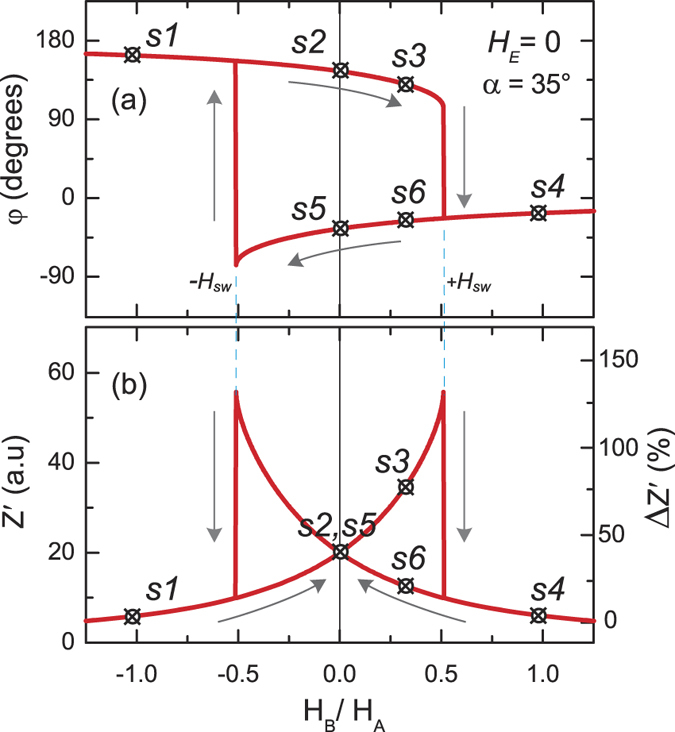
φ and Z′ dependences on HB calculated for anisotropy angle α = 35°.